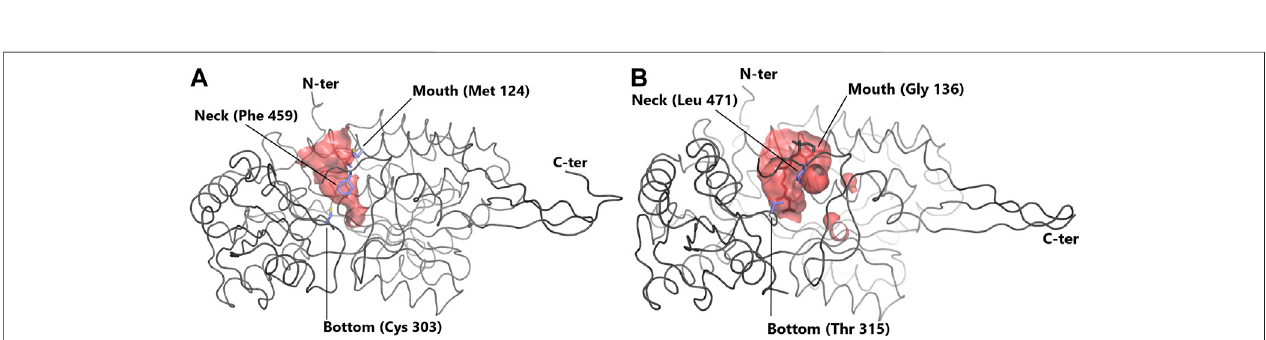
FIGURE 1 | ALDH architecture (A) Homodimeric structure of the human ALDH3A1 (PDB: 3SZA). (B) Homotetrameric structure of the human mitochondrial ALDH (PDB: 1NZX). (C) Three conserved domains illustrated on an ALDH monomer. The functional domains are highlighted: catalytic domain (blue), NAD(P) binding domain (purple), and oligomerization domain (green).